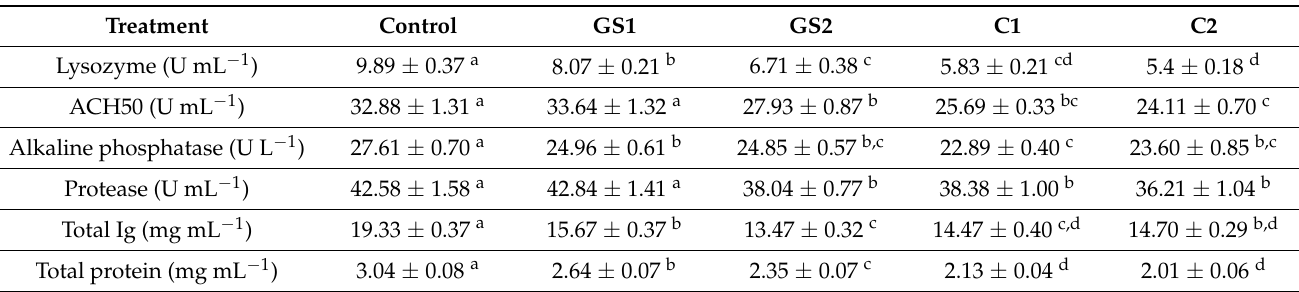
Table 3. Skin mucus immunological parameters (lysozyme, alternative complement activity (ACH50), alkaline phosphatase, protease activity, total Ig and total protein) of common carp exposed to waterborne concentrations of 0% (control), 25% and 50% of the LC 50 96 h (60 ppm) of commercially available ZnO-NPs (C1 and C2), and same concentrations of green synthesized ZnO-NPs (GS1 and GS2) for 21 days.